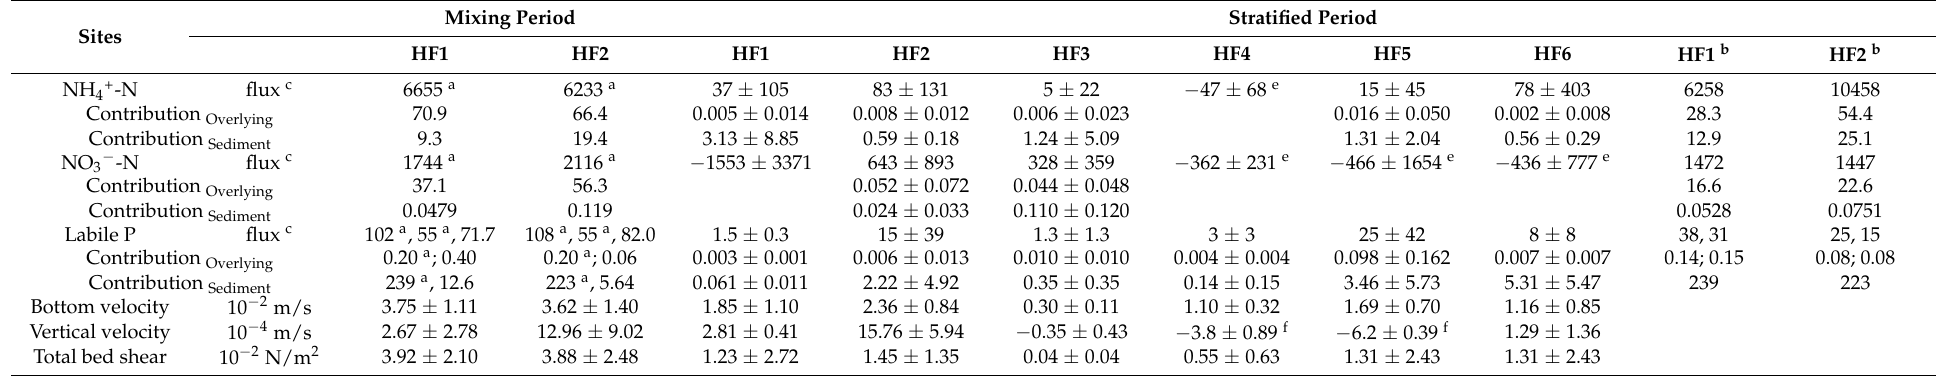
Table 2. Diffusion fluxes, their contribution to overlying water and sediment of NH 4+ -N, NO 3 − -N and labile P, bottom velocity, vertical velocity, and total bed shear at HF1~HF6, Hongfeng